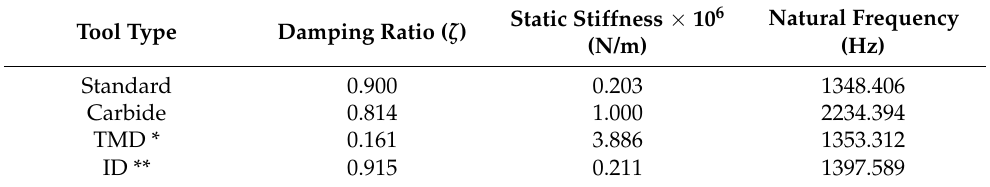
Table 2. Dynamic properties of different tools at the same overhang equal to TSC = 7.81 mm − 1